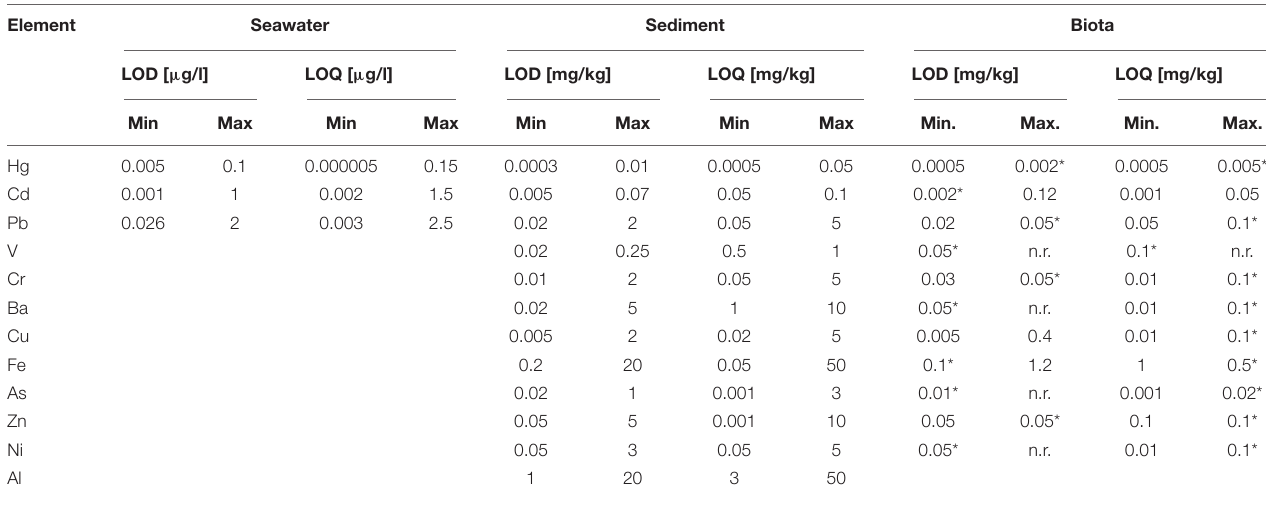
TABLE 3 | Minimum and maximum values of LOD and LOQ values for metals in seawater, sediment and biota ( Mytilus galloprovincialis ) among reporting laboratories; *values expressed as wet weight (to be multiplied by a factor of 5 for the comparison with d.w. units), otherwise as dry weight (for sediment and biota); n.r. – not reported. Element